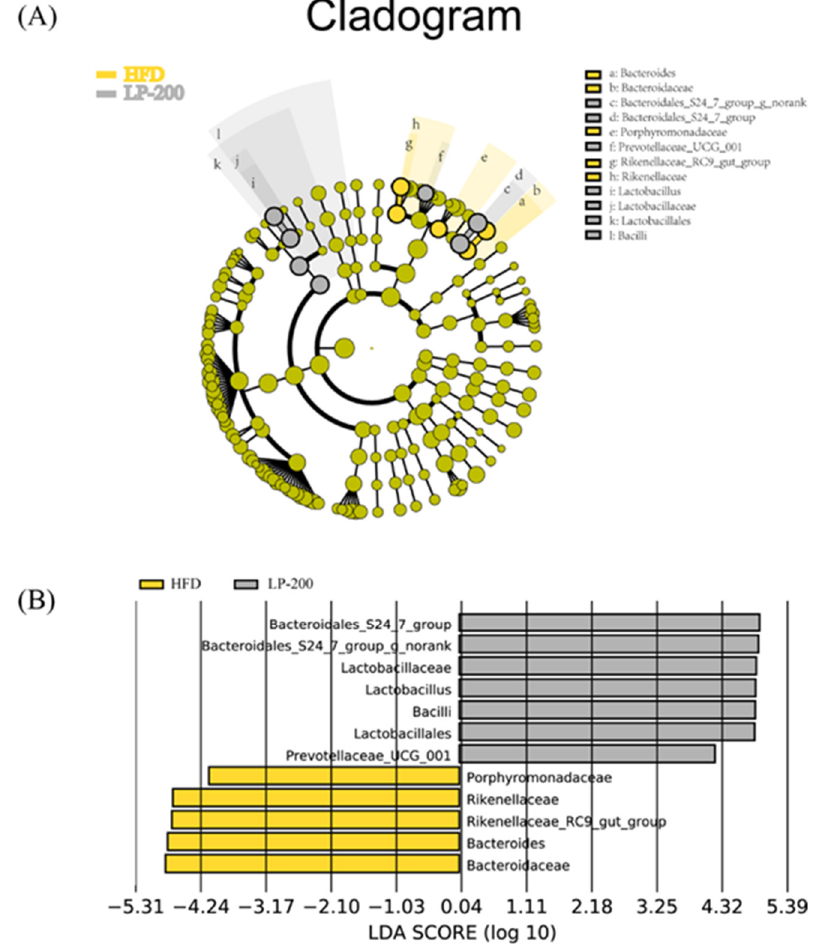
Figure 8. Cladogram ( A ) and LEfSe analysis ( B ) of mouse intestinal flora.